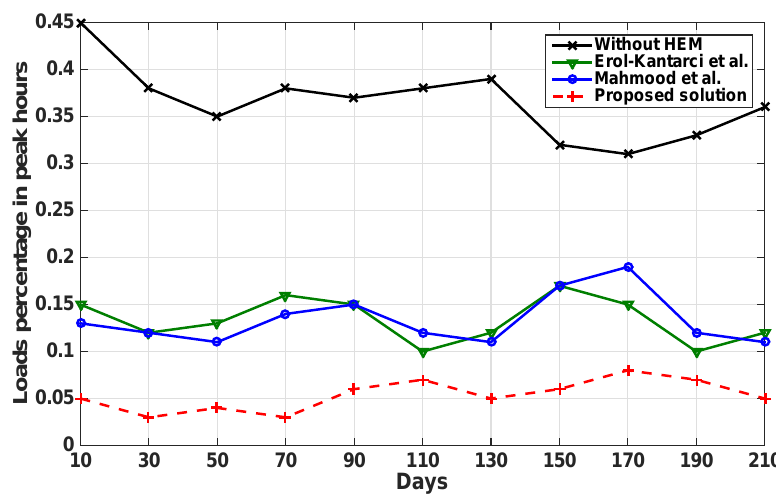
Figure 8. Load of the appliances ratio during peak hours.